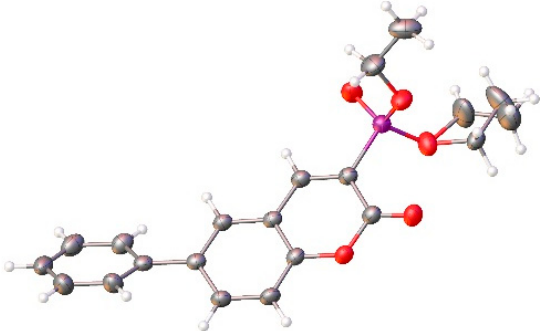
Figure 2. ORTEP representation with thermal ellipsoids 40%— Crystal Data for C 19 H 19 O 5 P (M = 358.333 g/mol): monoclinic, space group P2 1 /n (no. 14), a = 13.6869(9) Å, b = 8.5123(5) Å, c = 14.9033(9) Å, α = 90°, β = 90.726(2)°, γ = 90°, V = 1736.20(19) Å 3 , Z = 4, T = 133.00 K, μ (M oK α ) = 0.185 mm − 1 , D calc = 1.371 g/cm 3 , 26,401 reflections measured (4.06° ≤ 2 Θ ≤ 55.84°), 4155 unique (R int = 0.0591, R sigma = 0.0405) which were used in all calculations. The final R 1 was 0.0390 (I > 2 σ (I)) and w R 2 was 0.1092 (all data). The crystallographic data could be found in